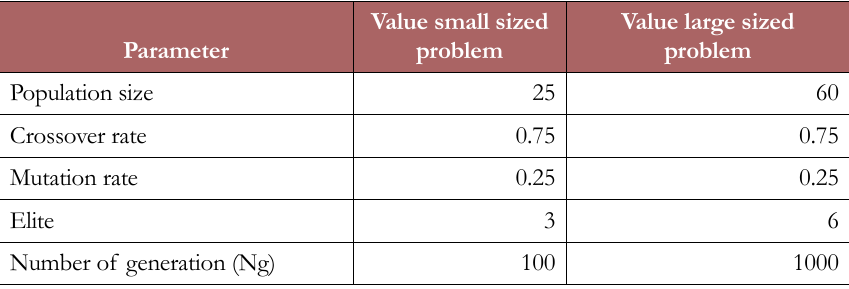
Table 2. Parameter used in developed